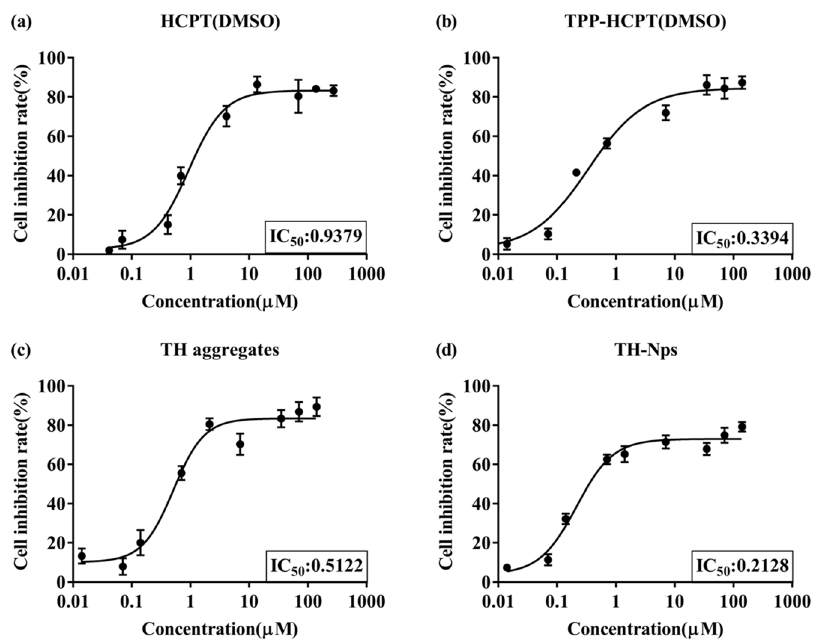
Figure 7. Cytotoxicity of HCPT (DMSO solution, ( a )) and TPP-HCPT (DMSO solution, ( b )), TH aggregates ( c ) and TH-NPs ( d ) against 4T1 cells after incubation for 48 h ( n = 3).